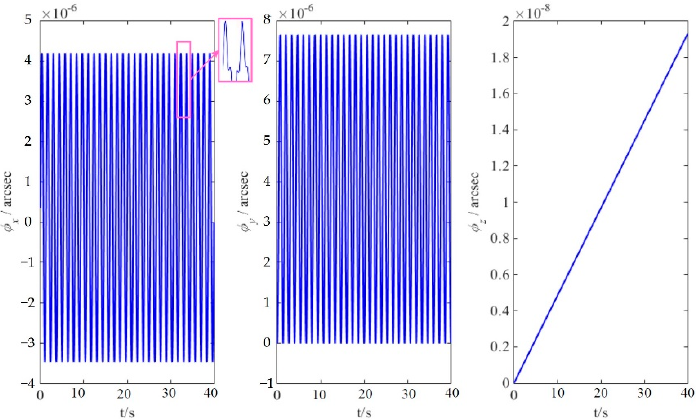
Figure 15. Shearer SINS coning error.